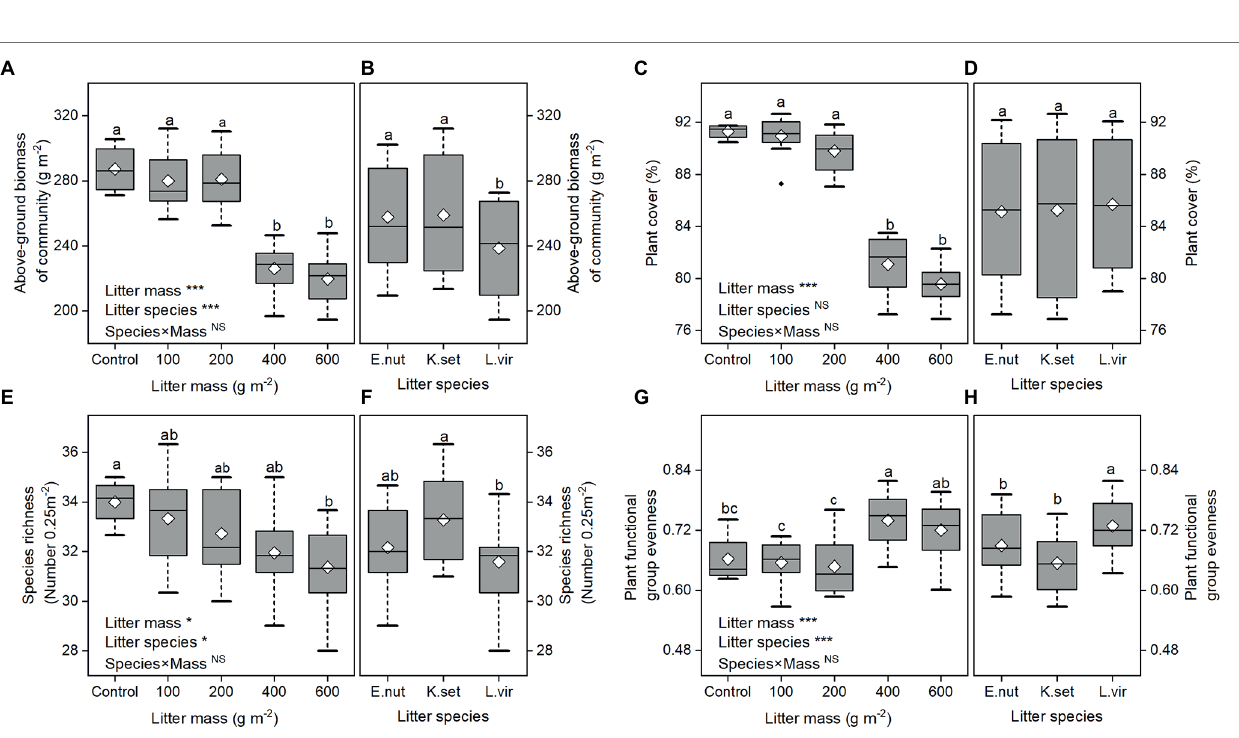
FIGURE 1 | Effects of litter mass (A) and species (B) on ecosystem multifunctionality. Lowercase letters indicate significant differences at p < 0.05 (*** p < 0.001; NS, not significant). Box plots show midline, mean; box edges, first quartile and third quartile; and whiskers, minimum and maximum. E. nut , E. nutans ; K. set , K. setchwanensis ; L. vir , L. virgaurea .